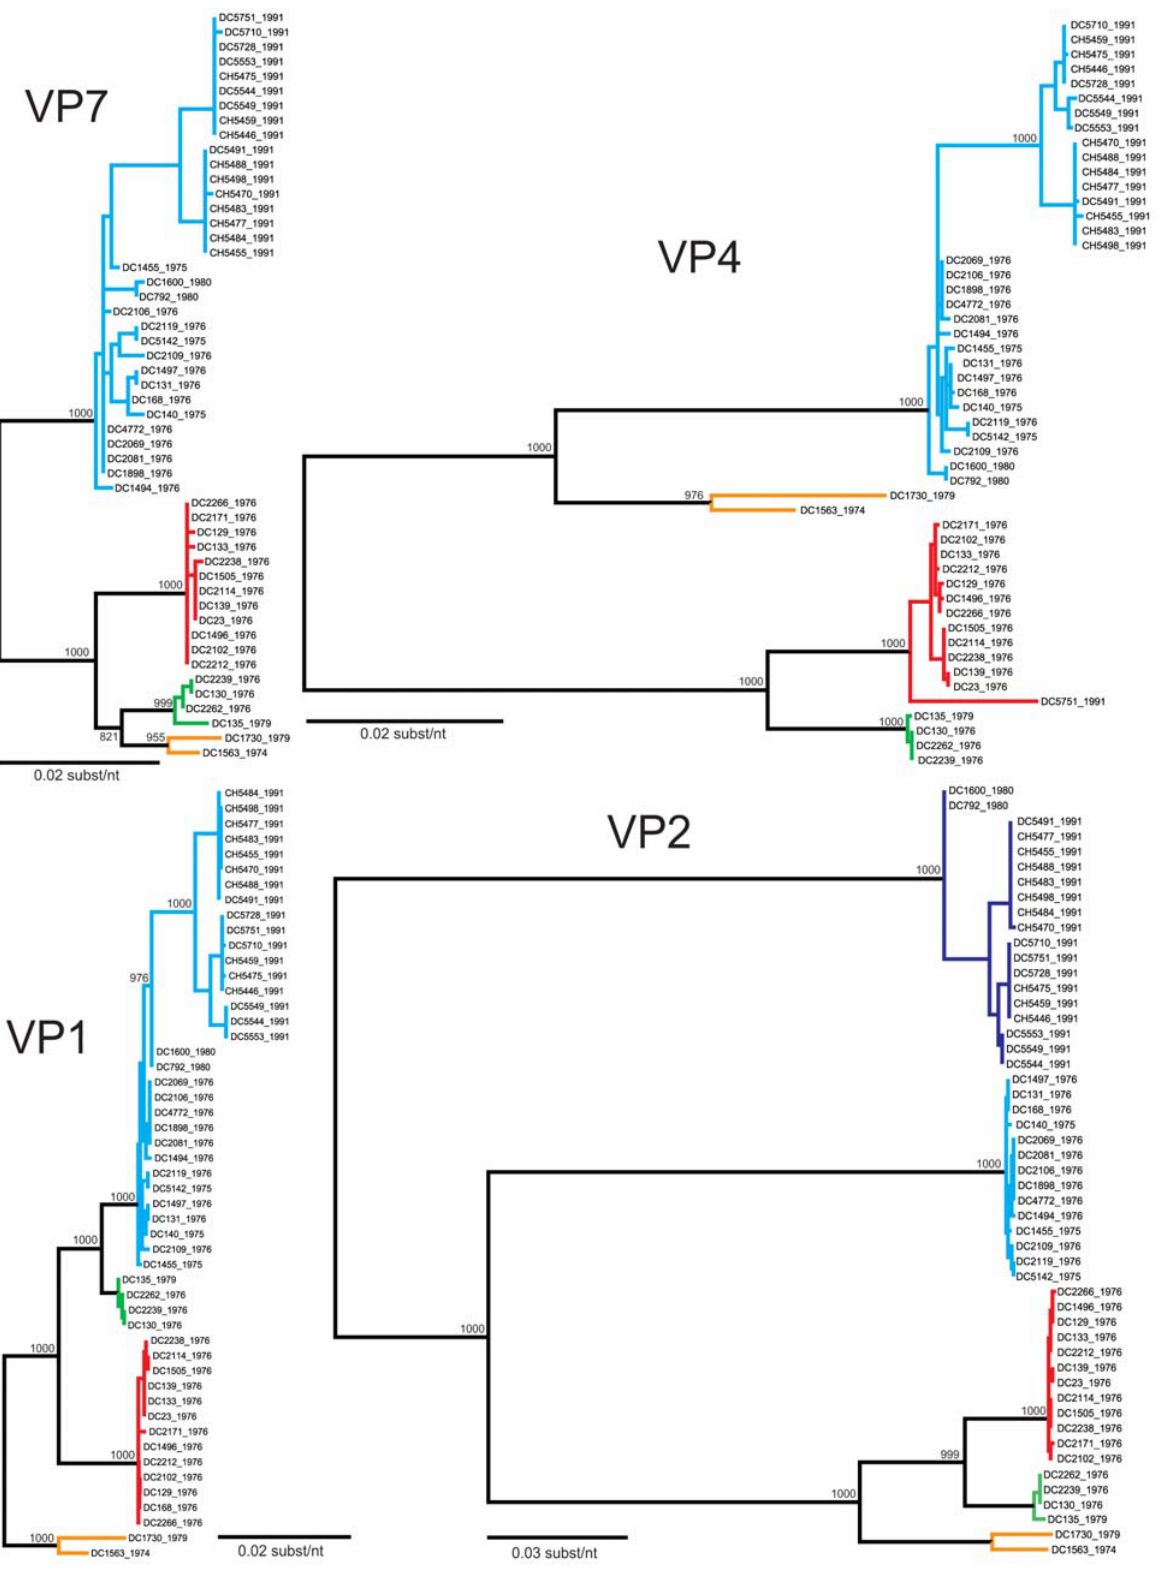
Figure 2. Phylogenetic Relationships Among the Individual Genes of the G3P[8] RVs: VP7, VP4, VP1, and VP2. The maximum likelihood trees were constructed using the ORF nucleotide sequences for each gene of each isolate and are mid-point rooted for purposes of clarity. All horizontal branch lengths are drawn to scale, and bootstrap values are shown per 1000 replicates for key nodes. Sequences that cluster together in all algorithms tested were assigned the same color (orange, green, red, cyan, or navy blue), and separate colors indicated divergent gene alleles.